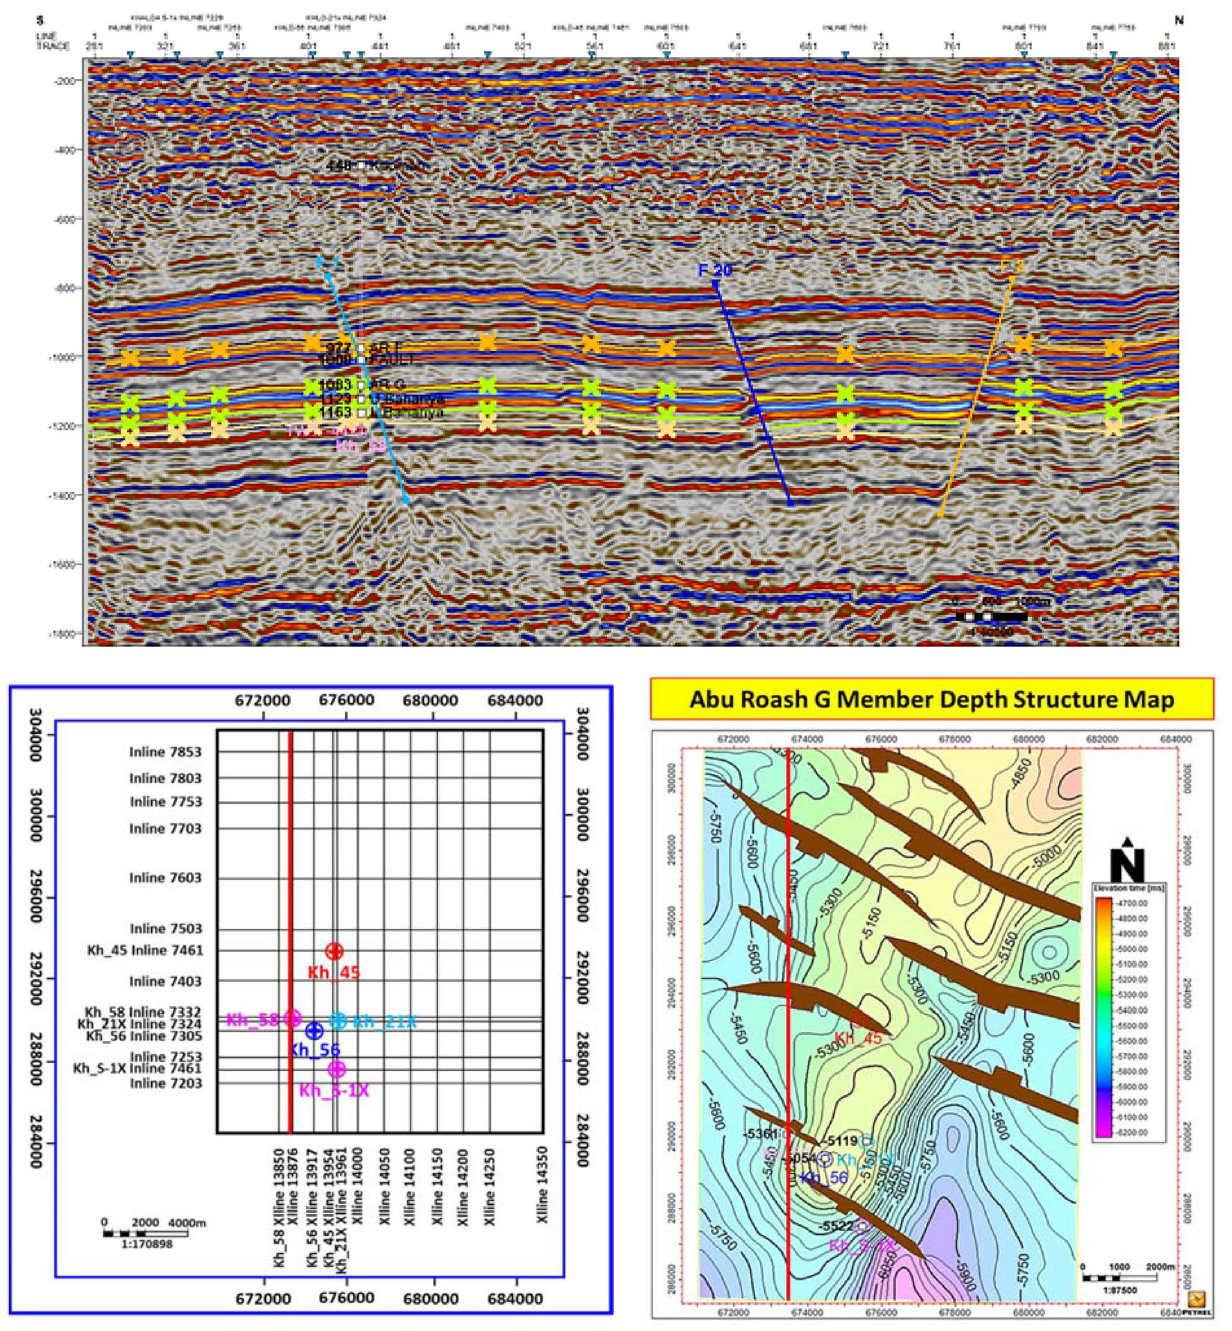
Fig. 12 The Interpreted TWT (msec.) seismic section that extends along the S–N direction, and passing through the KH_58 well. Interpreted and un-interpreted TWT (msec.) Seismic Section (XLINE 13,850), extend along the S–N direction, and passing through KH_58